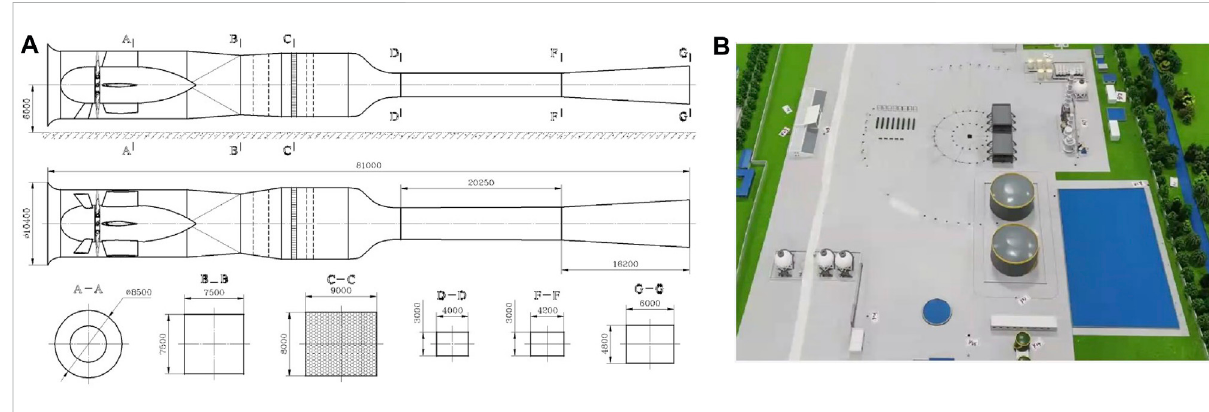
FIGURE 5 Models of the wind tunnel and experimental scene. (A) Design of the wind tunnel. (B) Physical miniature